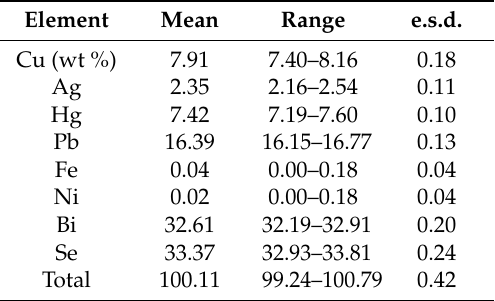
Table 2. Chemical data for cerromojonite.